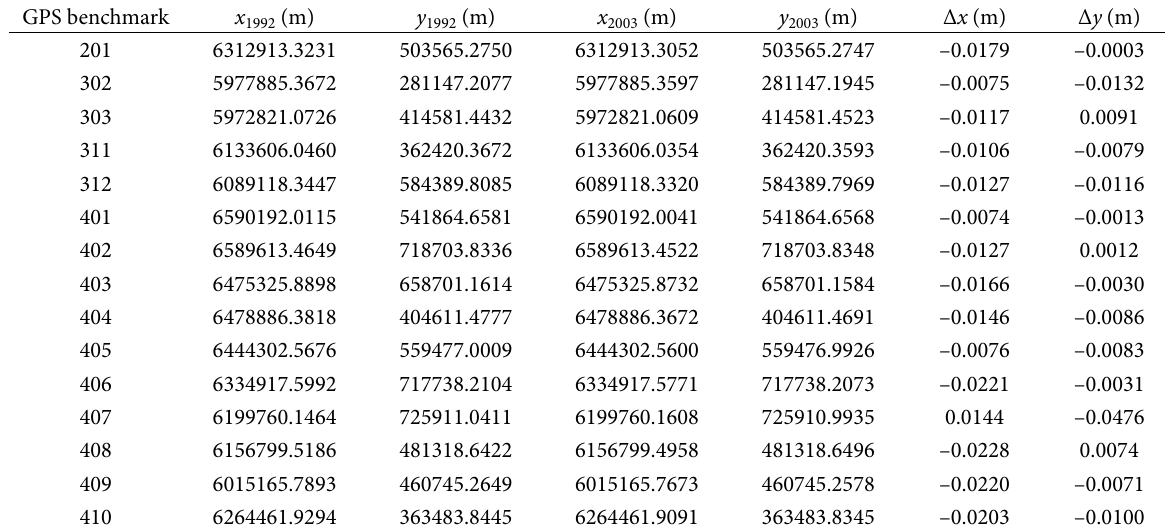
Table 1. Plane rectangular coordinates of GPS benchmarks and their changes GPS